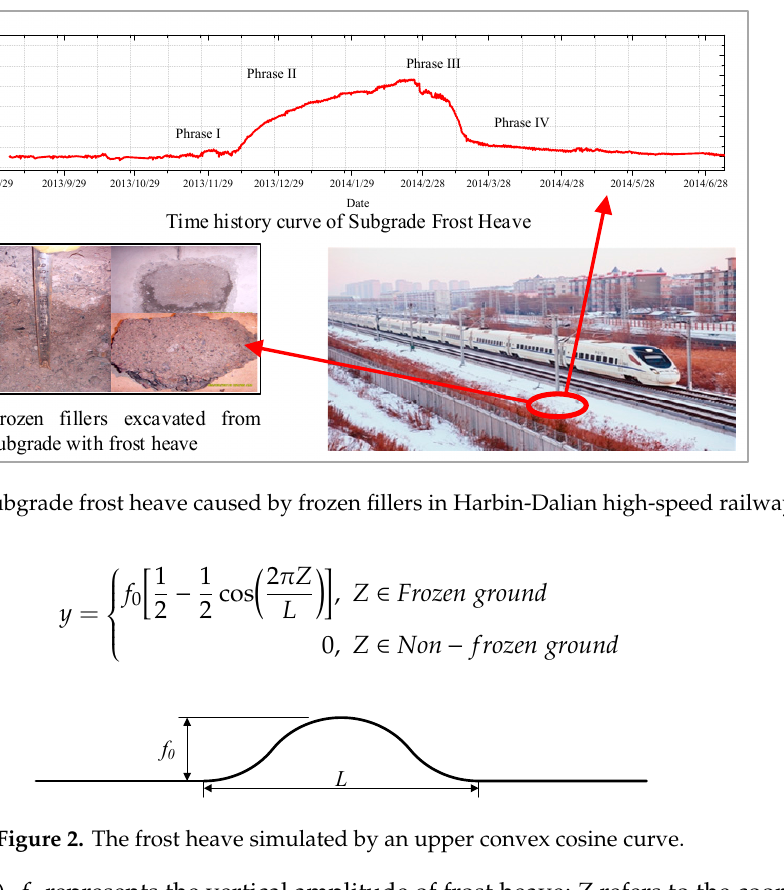
Figure 1. Subgrade frost heave caused by frozen fillers in Harbin-Dalian high-speed railway.